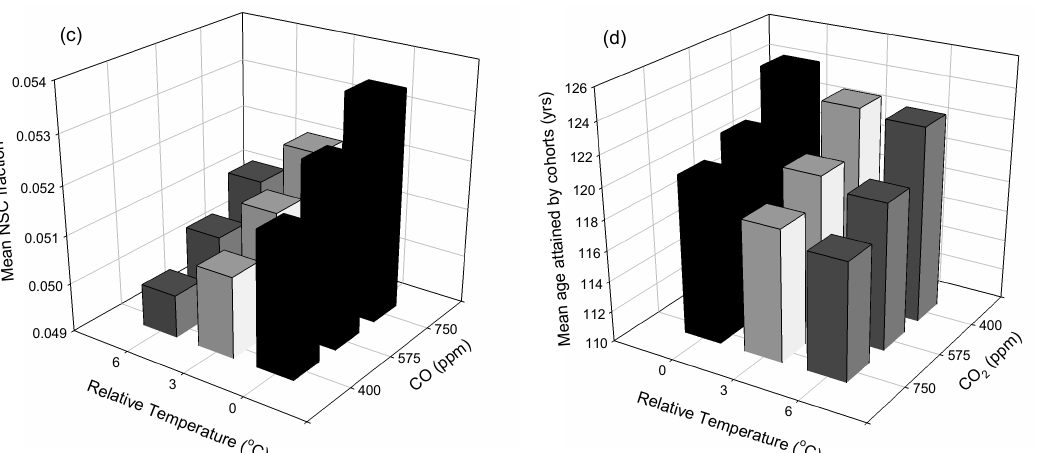
Figure 3. Mitigating effect of CO 2 on the negative temperature effect for the four response variables. Note axis inversion in ( d ).